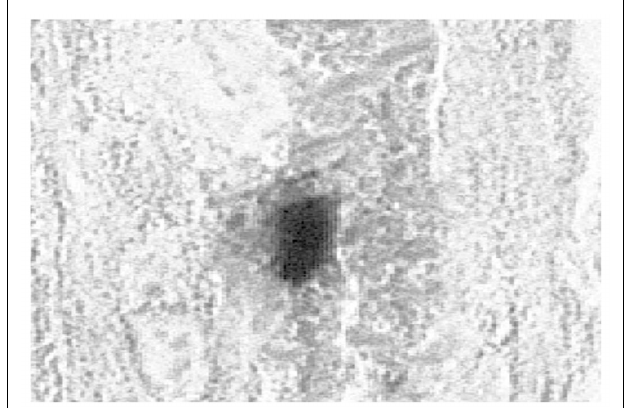
FIGURE 2 |ATUNEL-positive cardiomyocyte (nucleus) after ischemia–reperfusion in the left